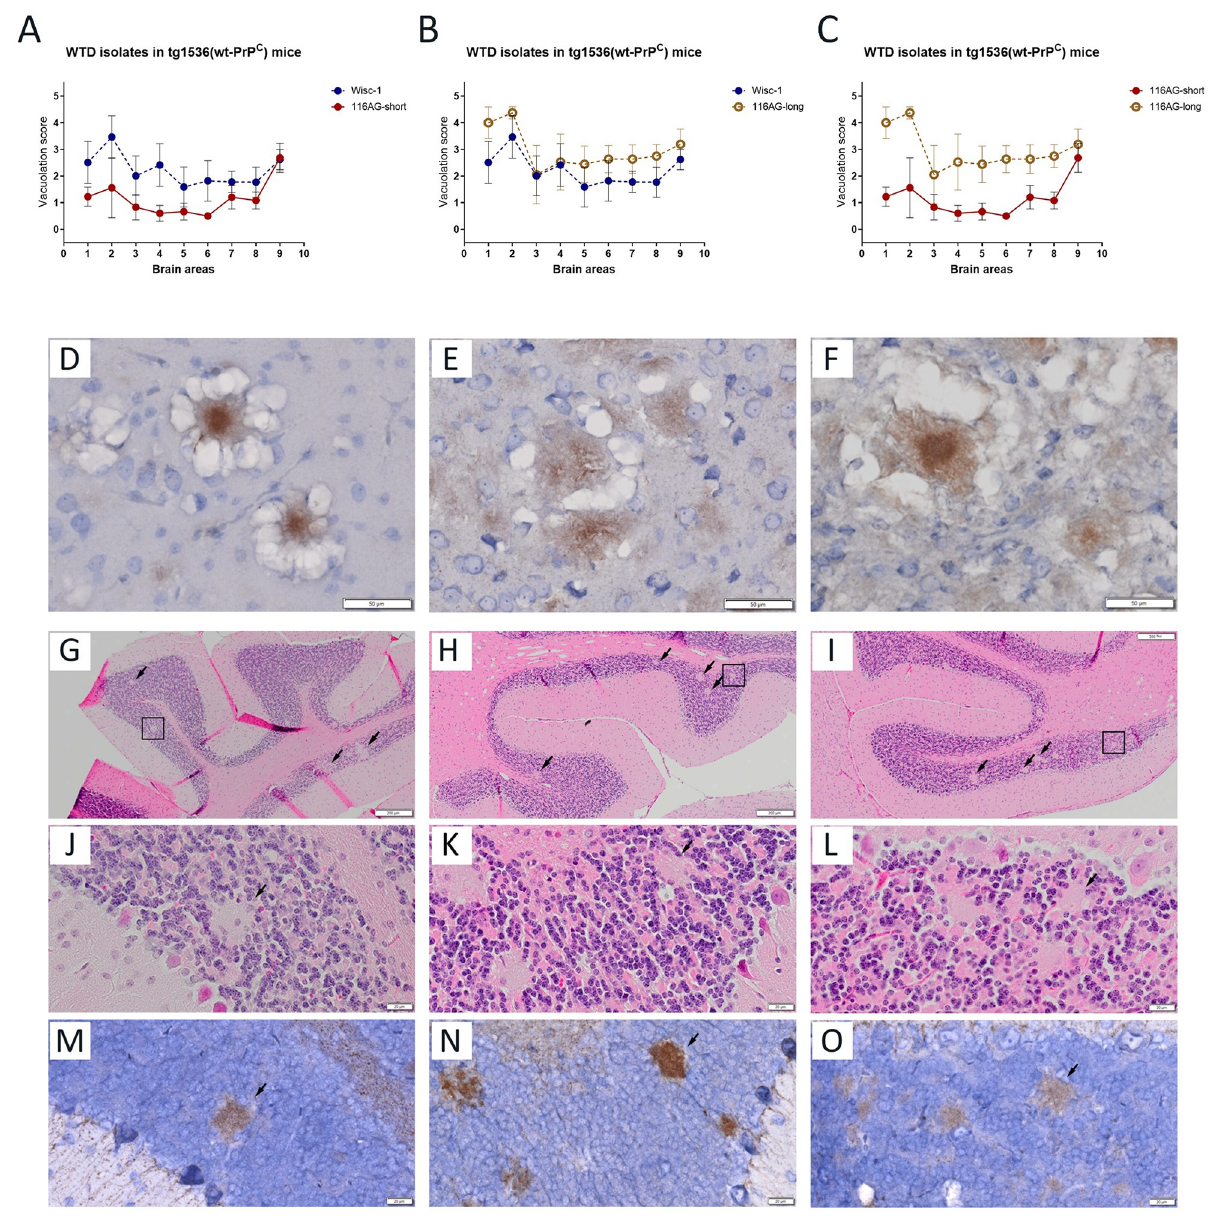
Fig 5. Strain characterization of tg1536 +/+ mice inoculated with Wisc-1 and 116AG isolates. Neuropathological profiles of brains of tg1536 +/+ animals inoculated with 10 − 4 dilution of Wisc-1 and 116AG prions, respectively, were determined. Brain vacuolation profiles comparing (A) 116AG- short and Wisc-1 inoculated mice, (B) 116AG-long and Wisc-1 inoculated mice, and (C) 116AG-short and -long inoculated mice. The y-axis represents vacuolation scores on a range of 0 to 5 in terms of spongiform changes (0 is none and 5 is severe). The x-axis represents the brain areas scored (1 frontal cortex, 2 basal ganglia, 3 parietal cortex, 4 hippocampus, 5 thalamus, 6 hypothalamus, 7 midbrain, 8 cerebellum, 9 medulla/pons). The scoring was performed in a blinded manner at least six times (range 6–8). Each curve represents each group, and each data point is the mean vacuolation score ± standard deviation. (D-F) Presence of florid plaques after PrP Sc immunostaining using 12B2 mAb in the frontal cortex brain sections of mice inoculated with (D) Wisc-1, (E) 116AG-short and (F) 116AG-long prions. (G-O) Presence of unicentric plaques in the granular layer of the cerebellum of mice inoculated exclusively with 116AG-long. (G-I) H&E staining of three representative brains from mice inoculated with serially diluted brain homogenate of 116AG-long prions (10 − 3 , 10 − 4 and 10 − 5 ). The unicentric plaques are indicated with black arrows and black squares. (J-L) H&E staining showing unicentric plaques highlighted by squares at a higher magnification. (M-O) PrP Sc immunostaining using 12B2 mAb of the unicentric plaques in the granular layer of the cerebellum at a higher magnification. Scale bars indicate 20 μ m and 50 μ m for high magnification and 200 μ m.